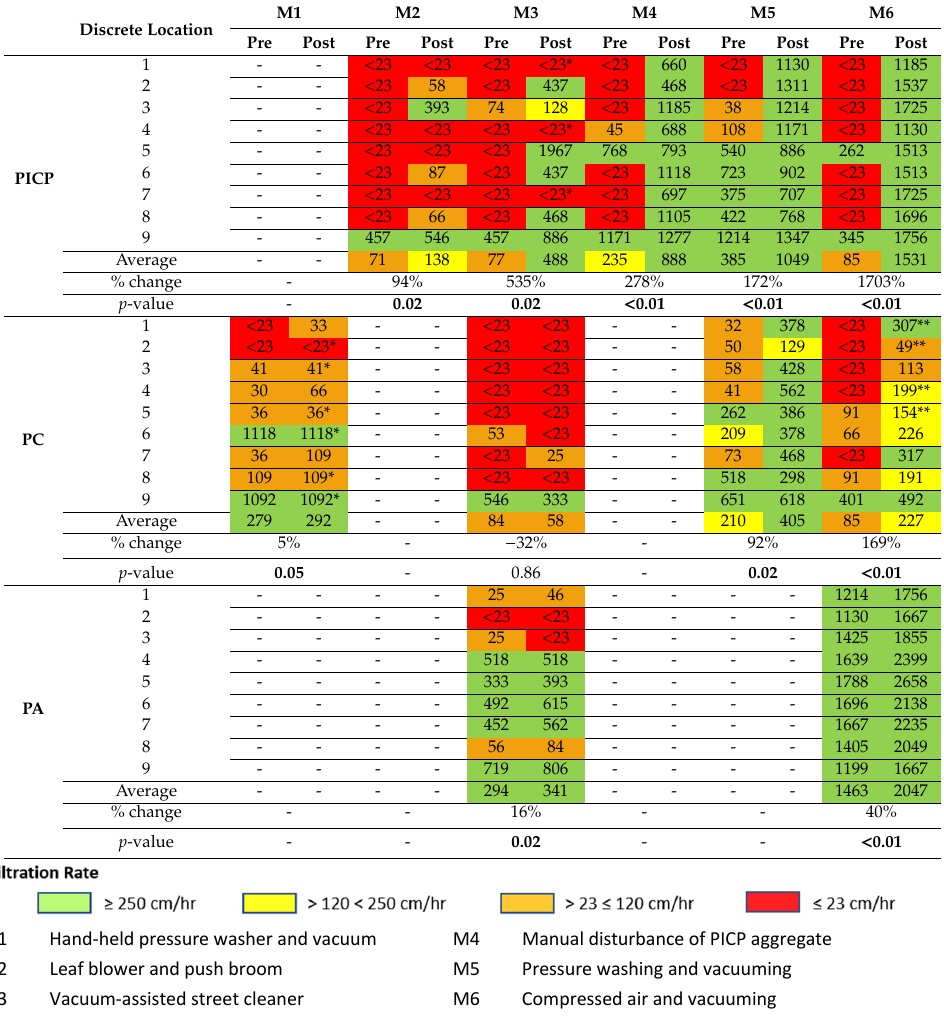
Table 1. Infiltration rates before and after each restorative maintenance practice as measured at the discrete locations and the results of average surface infiltration rate and percent change at the permeable interlocking pavers (PICP), pervious concrete (PC), and porous asphalt (PA) test plots (-, no tests done; * no treatment performed on discrete location; ** treatment duplicated on discrete location; values in bold indicate a significant increase in infiltration capacity at the 95% confidence level; a negative value indicates a decrease in infiltration capacity; cm / h, centimeters per hour).